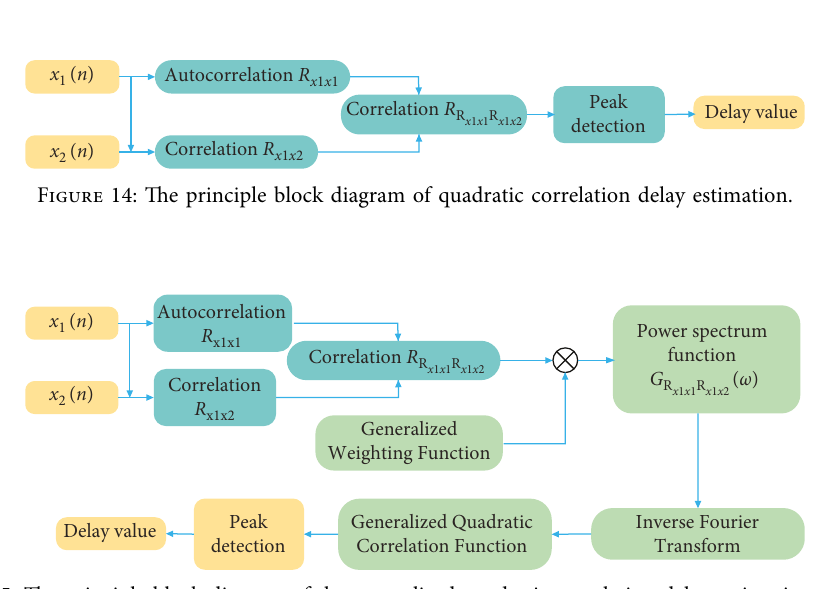
Figure 15: The principle block diagram of the generalized quadratic correlation delay estimation algorithm.